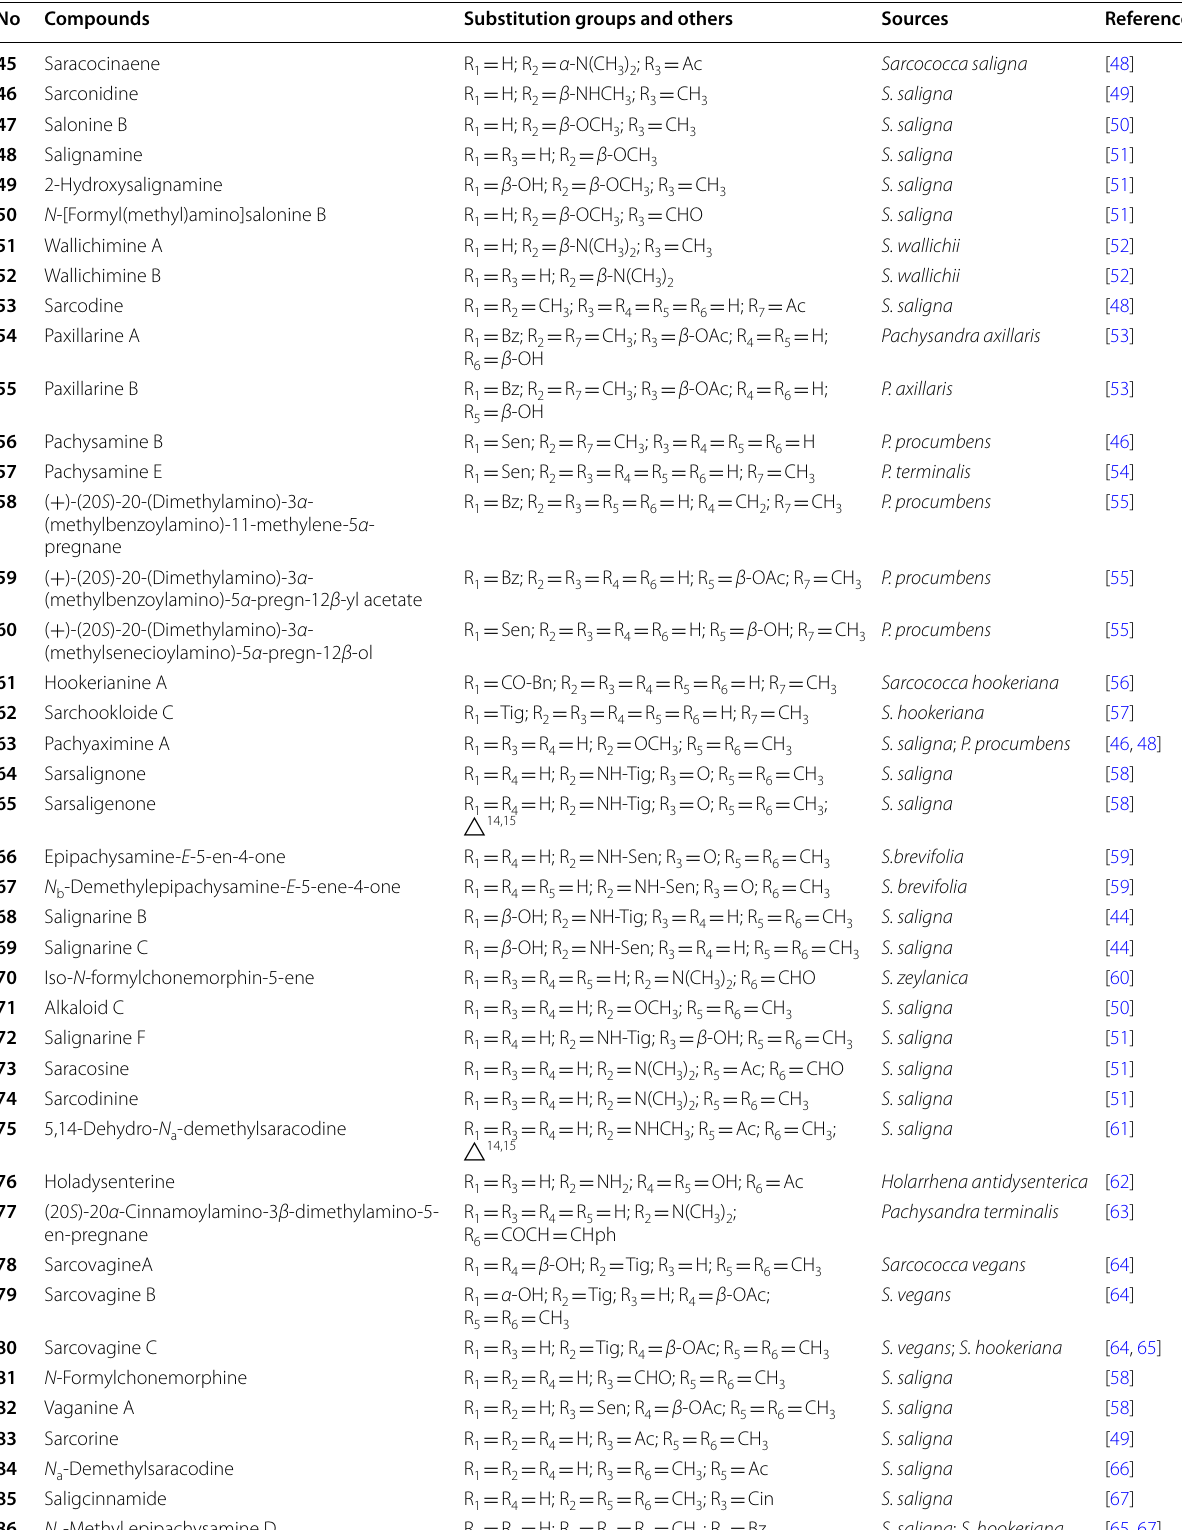
Table 3 Structures and sources of pregnane type steroidal alkaloids 45–177 No